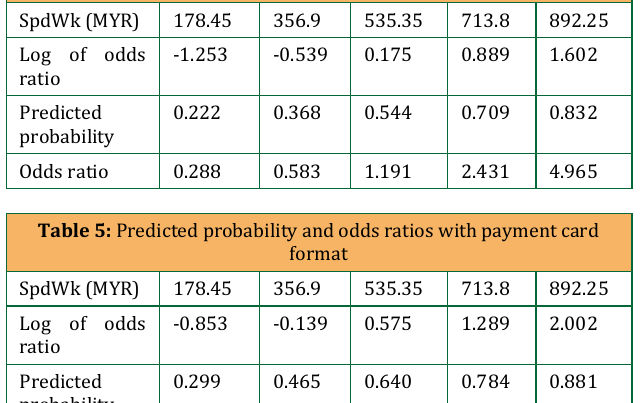
Table 4: Predicted probability and odds ratios with open-ended format